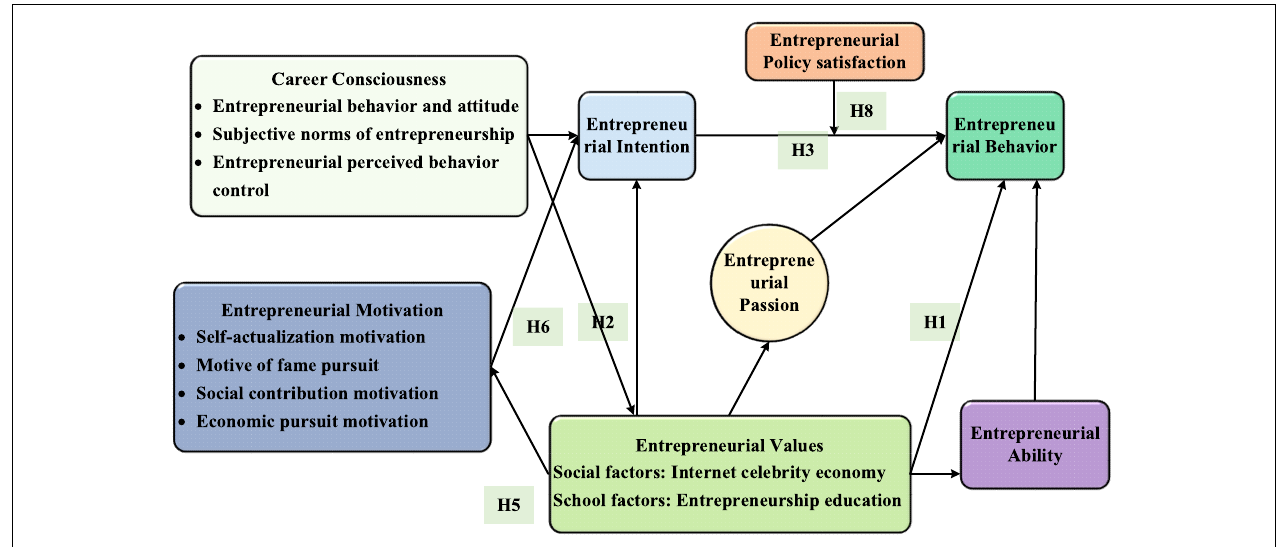
FIGURE 2 | Theoretical model of the influence mechanism of college students’ entrepreneurial values on entrepreneurial behavior.